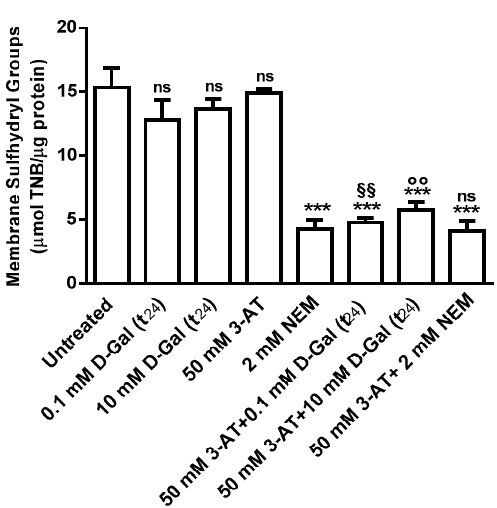
Figure 4. Membrane sulfhydryl groups content ( μ mol TNB/ μ g protein) in untreated (control) and in 0.1 or 10 mM D -Gal(t 24 )-treated erythrocytes. ns, not significant versus control or 2 mM NEM, *** , p < 0.001 versus control, §§ , p < 0.01 versus 0.1 mM D -Gal (t 24 ) and °° , p < 0.01 versus 10 mM D -Gal (t 24 ) as determined by one way ANOVA followed by Bonferroni’s post hoc test ( n = 6).